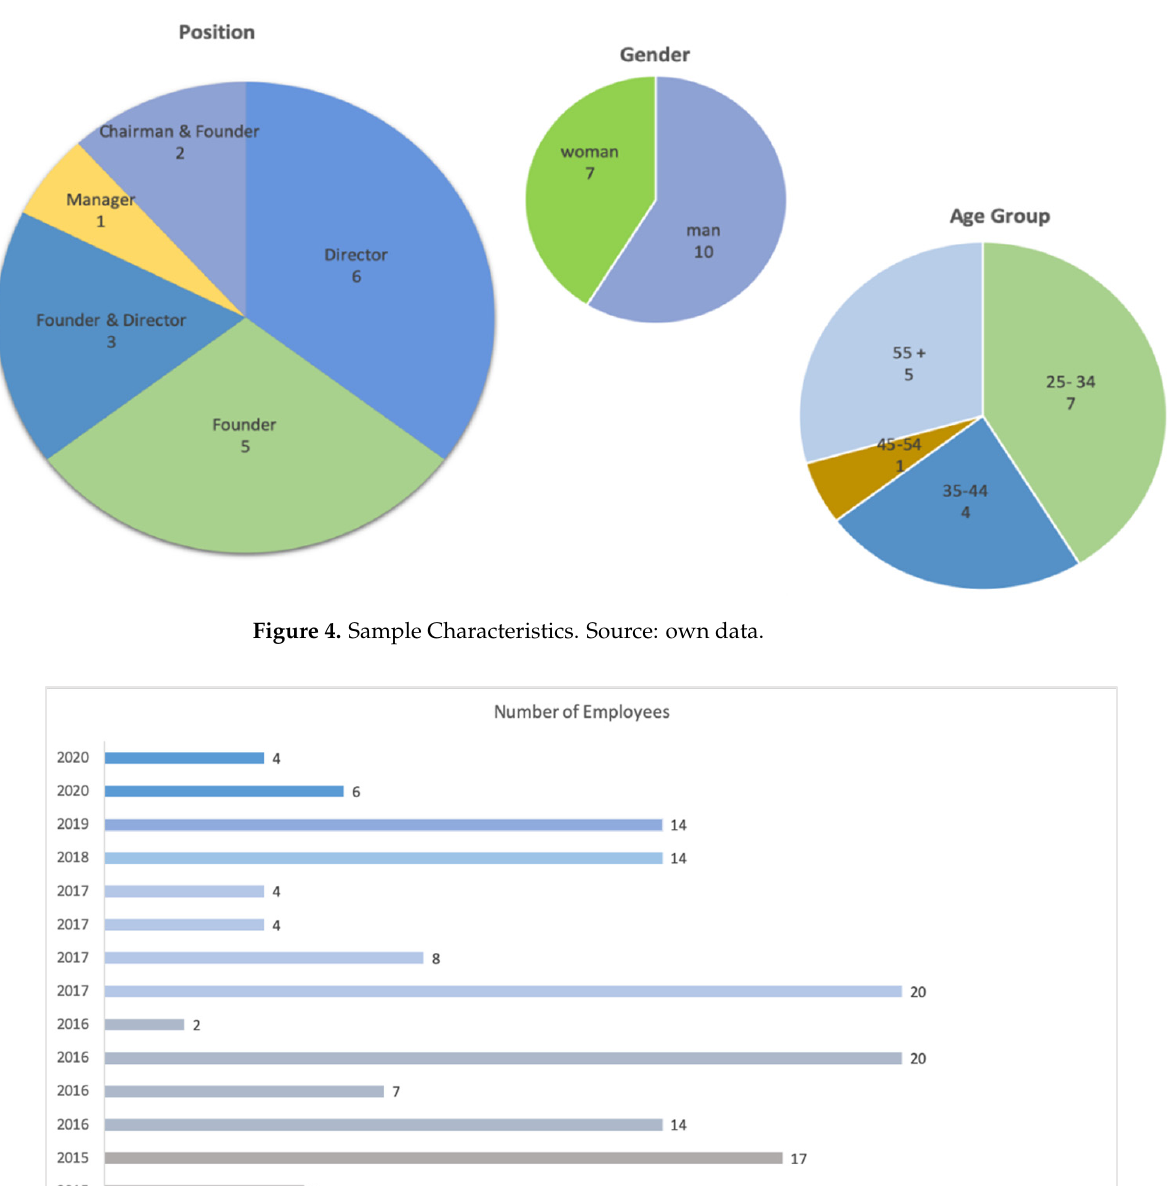
Figure 5. Characteristics of the Interviewed Social Enterprises: Number of Employees and Year of Foundation. Source: own data.